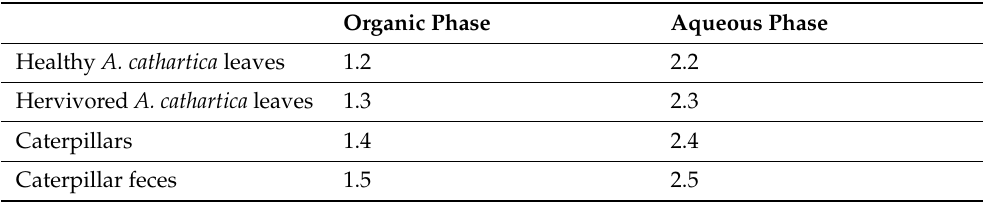
Table 3. Phases obtained for each manipulation after liquid–liquid extractions. Organic Phase Healthy A. cathartica